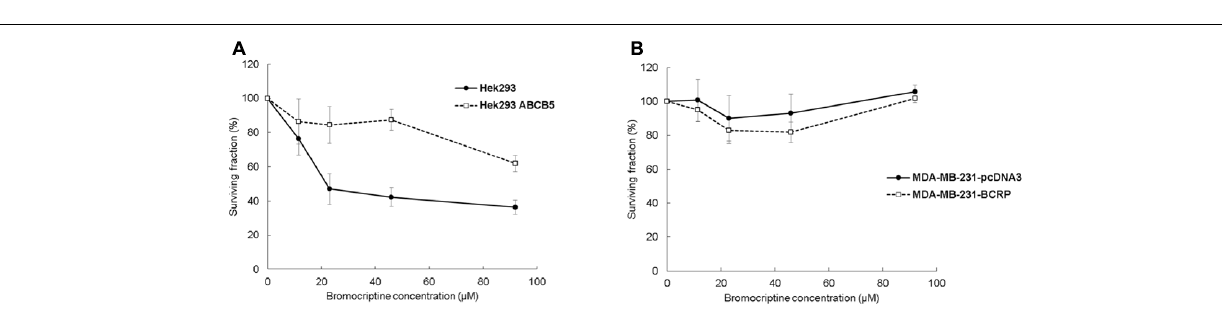
Frontiers in Pharmacology |